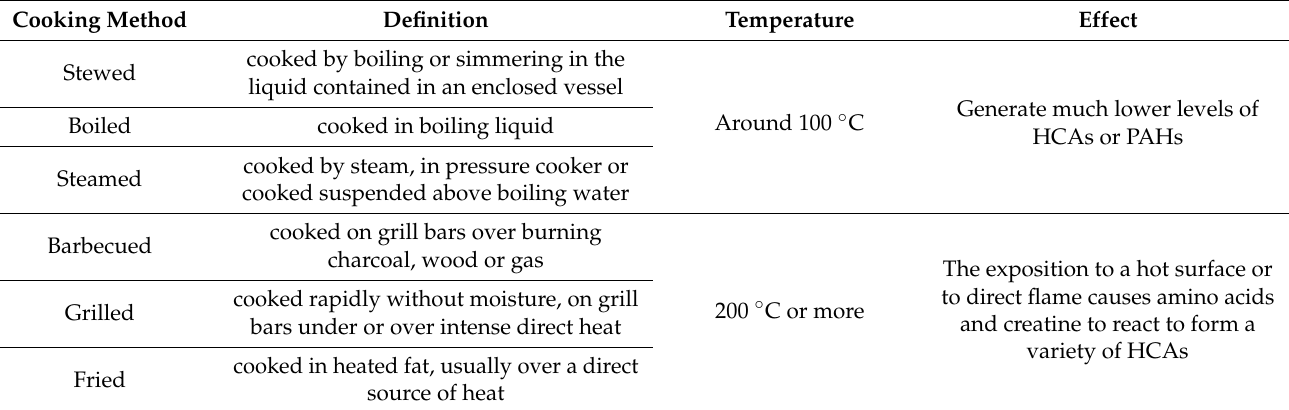
Table 3. The different cooking methods and the influence on the production of potential